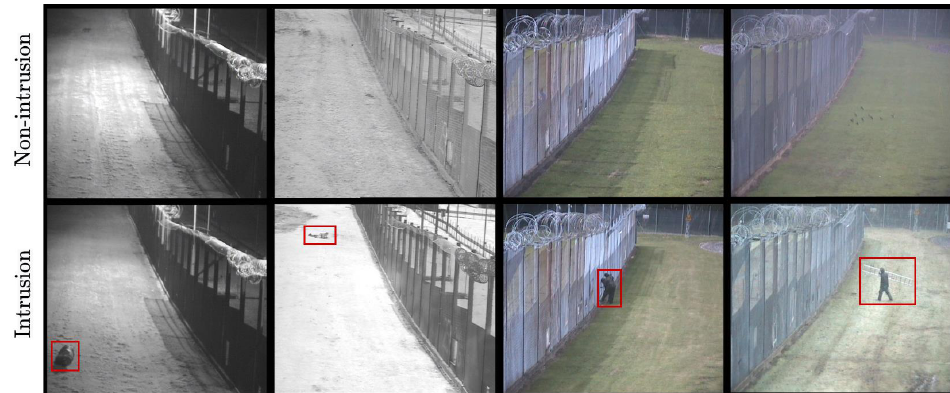
Figure 2. Some raw frames drawn from i-LIDS sterile zone dataset [26] with various intrusion (intruders in red boxes) and non-intrusion frames. The black and white and color frames belong to view 2 and view 1, respectively. The time of the day in four columns are night, day, dawn and dusk. The distractions in non-intrusion row (left to right order) are fox, insect on camera, shadow on fence and birds with rain, respectively. In intrusion row (left to right order), we have log rolling intruder, crawling intruder, two intruders and intruder with ladder during snow, respectively.